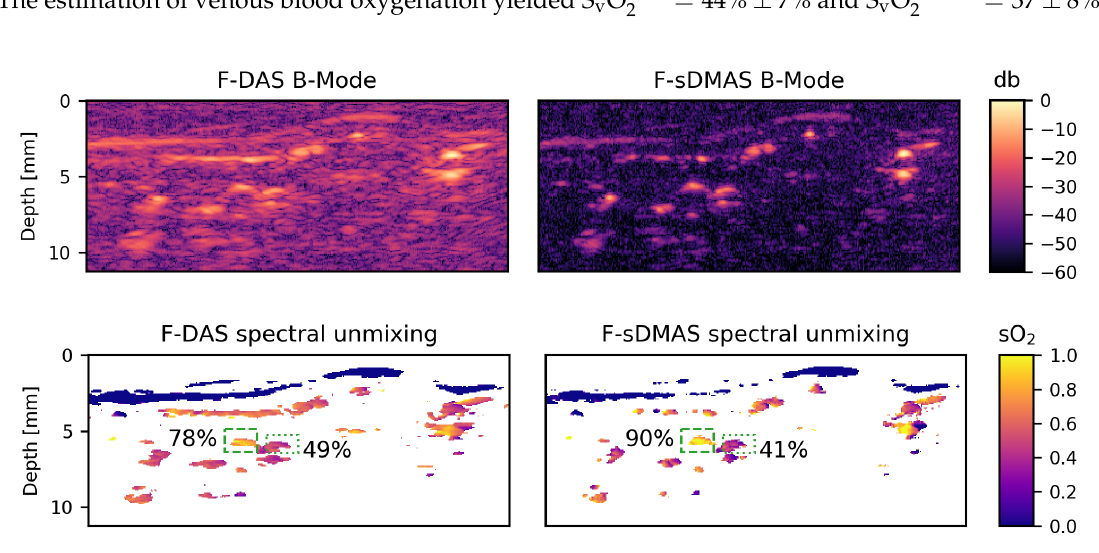
Figure 5. The radial artery and accompanying vein of a healthy human volunteer. Representative B-Mode images recorded at an acquisition wavelength of 831nm are shown in the top row. Beamforming was performed using Hanning apodization and the images where postprocessed with a bandpass filter (F). In the second row, blood oxygenation (sO 2 ) is visualized. Only values with high total hemoglobin as determined by the spectral unmixing are shown. The dashed green box marks the artery and the dotted line the accompanying vein as identified by a consulting physician; both are annotated with the median oxygenation within these